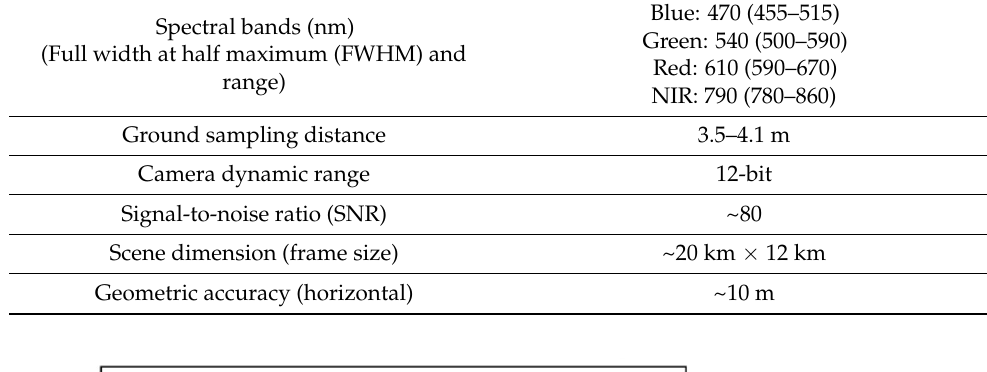
Table 1. Technical specifications of PlanetScope (PS) Dove Classic imagery (adapted from [37]).